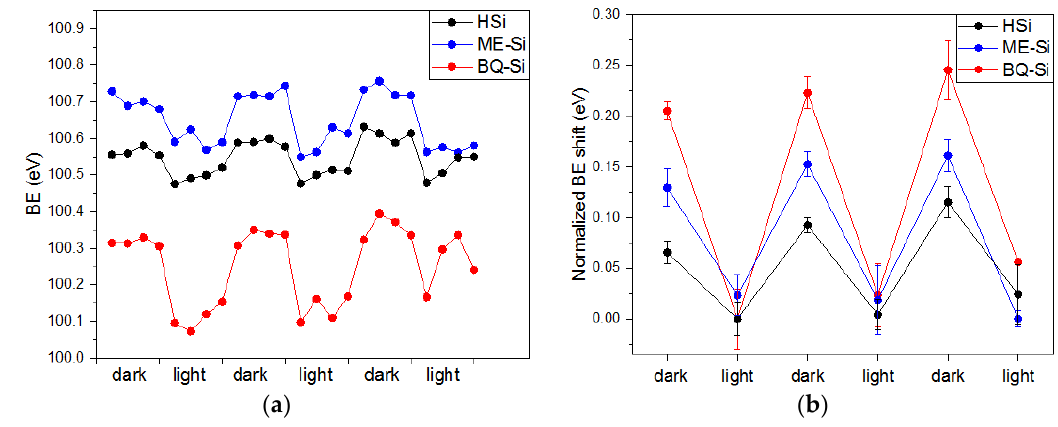
Figure 3. Si 2p binding energy ( a ) and normalized binding energy shift ( b ) in repetitive dark and light conditions.